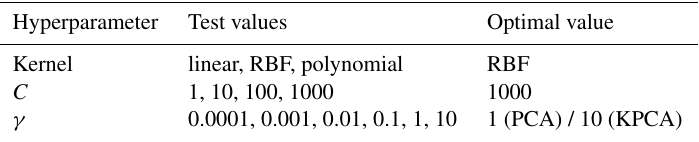
Table 4. Hyperparameter choices considered for the SVM classifier.